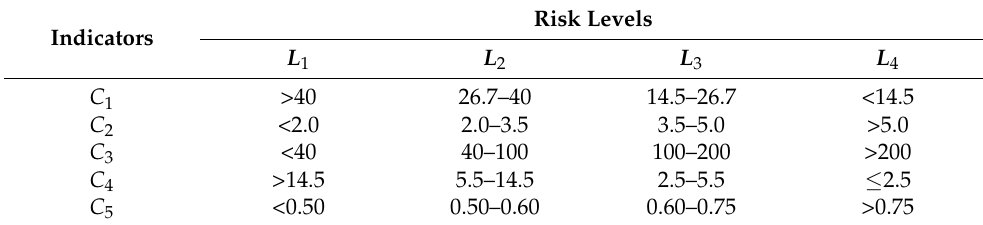
Table 1. Interval of indicator values corresponding to each level.